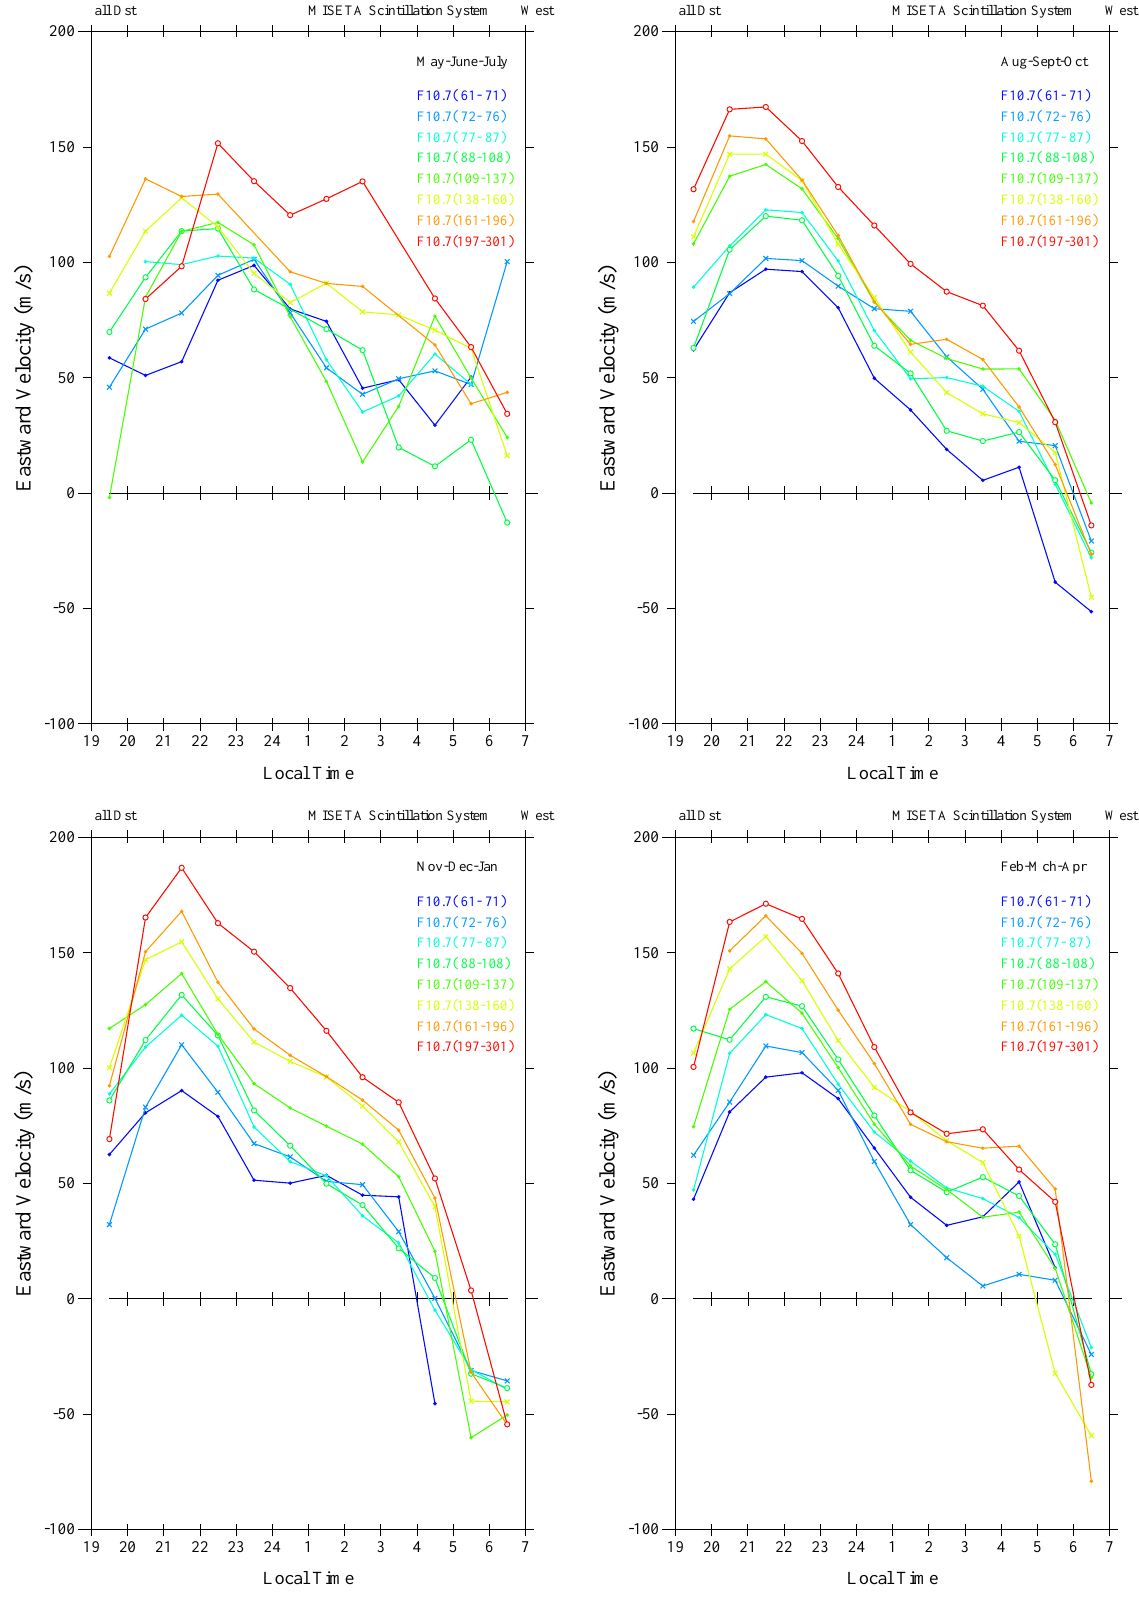
Fig. 2. Seasonal average zonal drifts for Ancon-W vs. local time (LT=UT − 5h) binned into 8 levels of solar flux